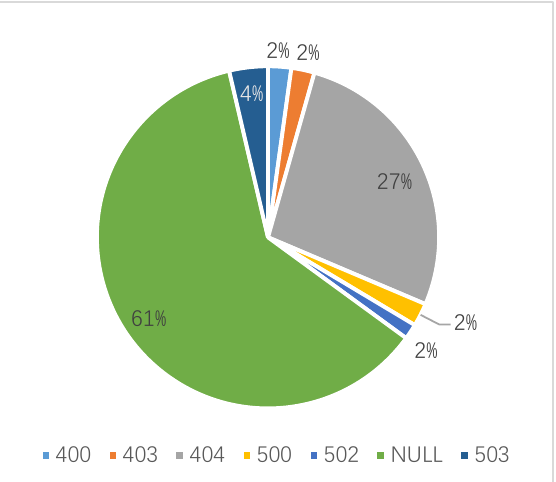
Figure 6. Distribution of status code of access error for domain names of Wuhan